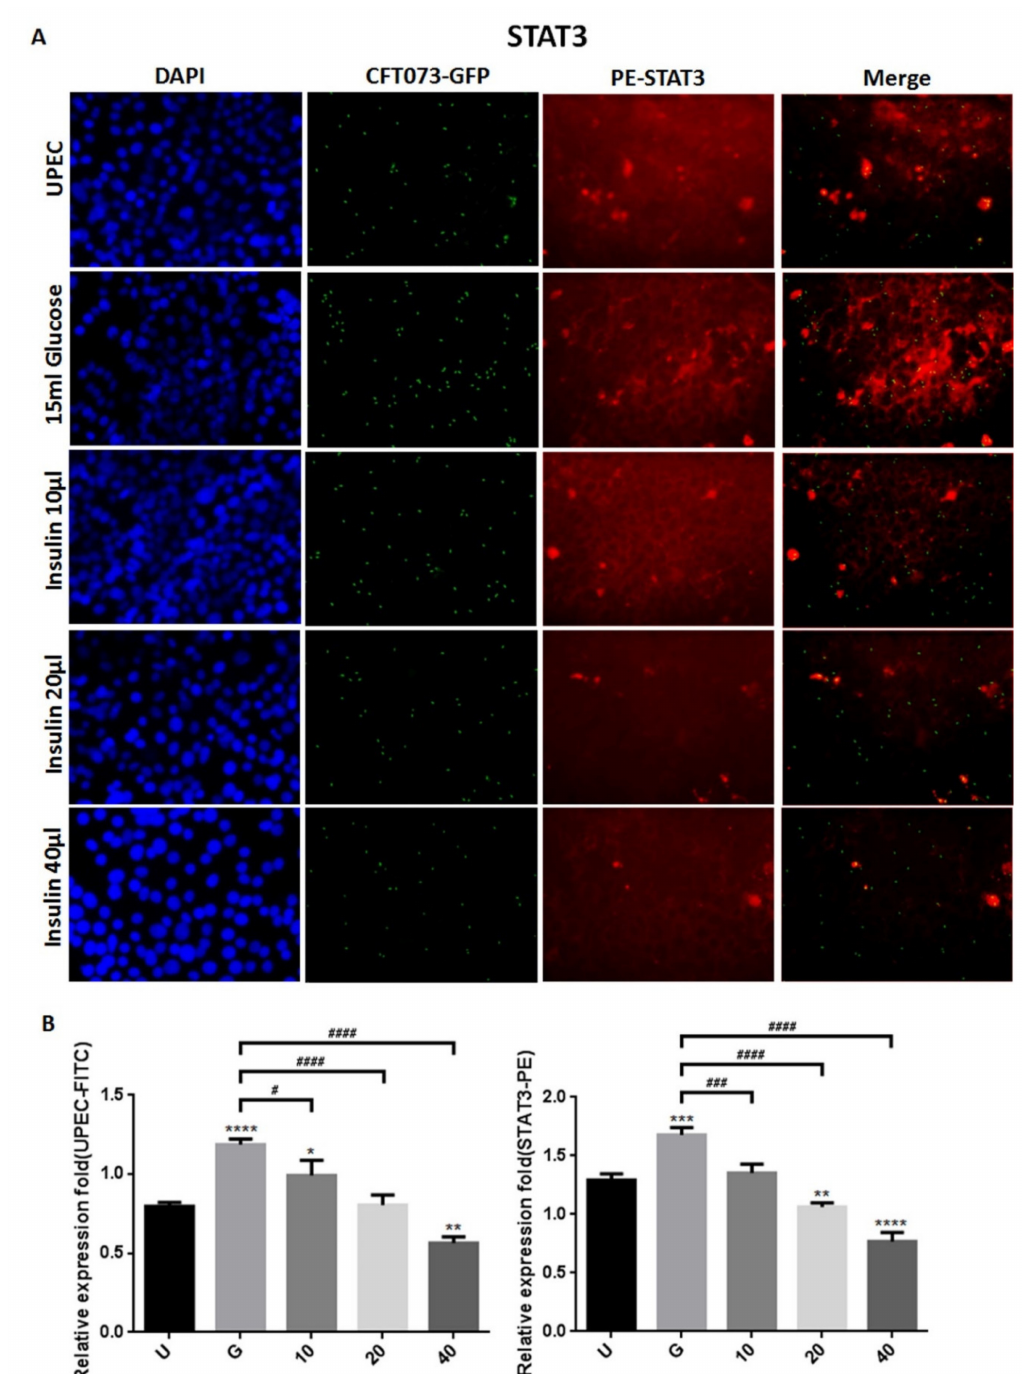
Figure 3. Insulin affected UPEC infection and STAT3 expression in bladder cells. After 24 h of pretreatment with different concentrations of insulin and 15 mM glucose, GFP-UPEC and PE-STAT3 expression in SV-HUC-1 cells post-infection were ( A ) observed by fluorescence microscopy and ( B ) measured using ImageJ software. Cells infected with UPEC alone were used as the positive controls. The data shown are representative of a typical result. DAPI was used to count the number of cells and as a standard for calculating the fluorescence expression ratio of cells. Cell images were captured using a microscope (Leica) at 100 × magnification. Data are expressed as mean ± SD from three separate experiments. The definitions of each letter/number represented by the X axis are: U: UPEC infection alone; G: with 15 mM glucose pretreatment; 10, 20 and 40: pretreated with 10, 20 and 40 µ g/mL insulin, respectively + 15 mM glucose. * p < 0.05; ** p < 0.01, *** p < 0.001, **** p < 0.0001, compared to positive control groups. # p < 0.05, ### p < 0.001, #### p < 0.0001, compared between the two